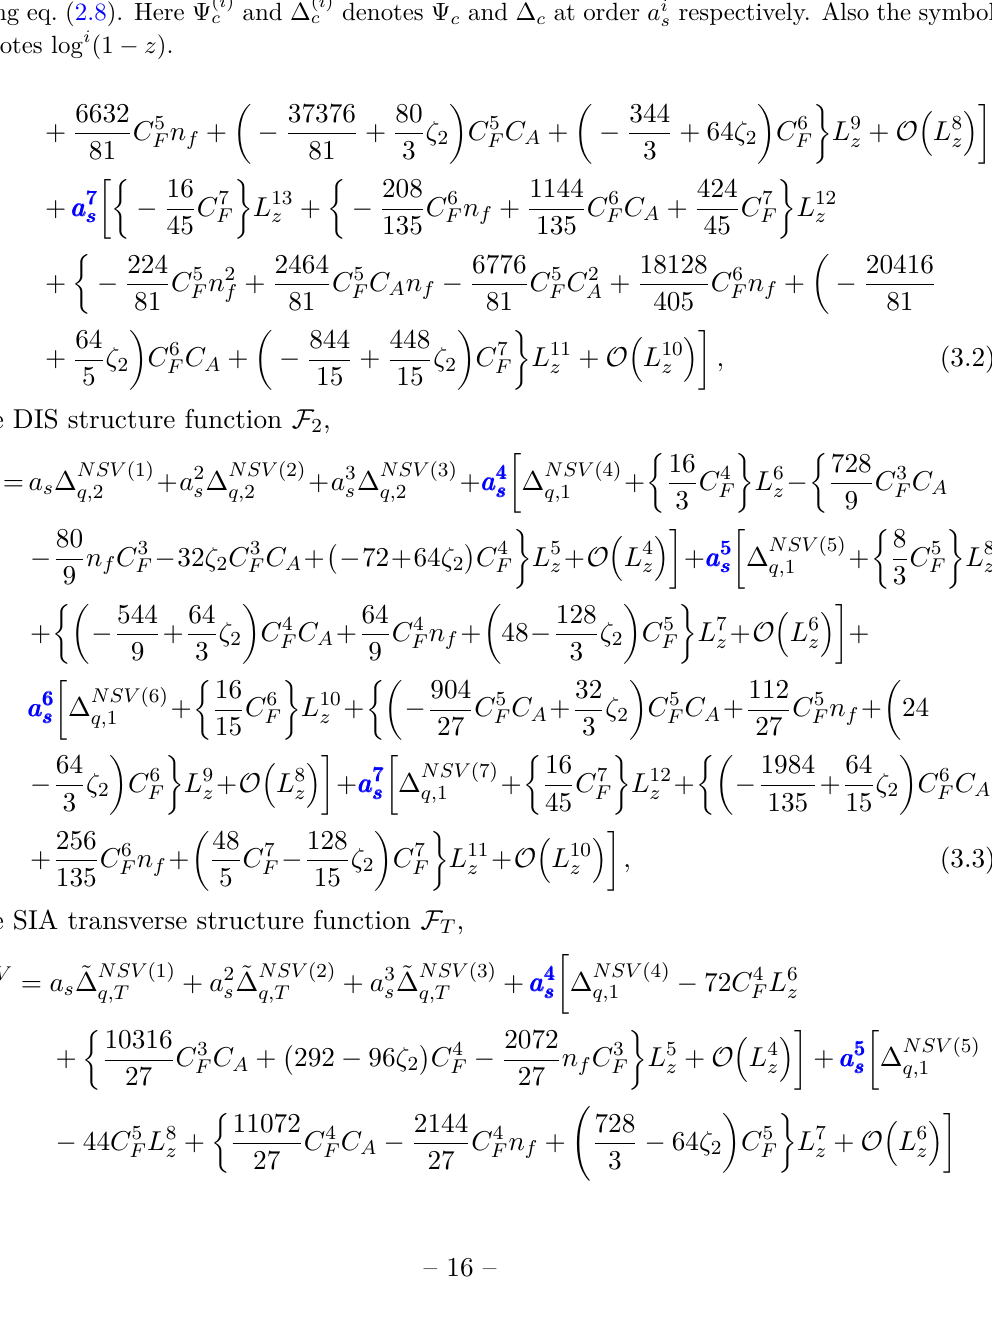
respectively. Also the symbol s